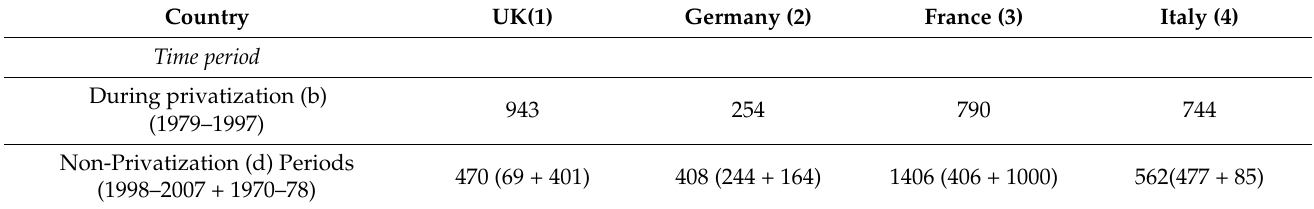
Table A2. Robustness test for Table 2 Total and per Year Number of Fatalities from Multi-fatality Disasters,